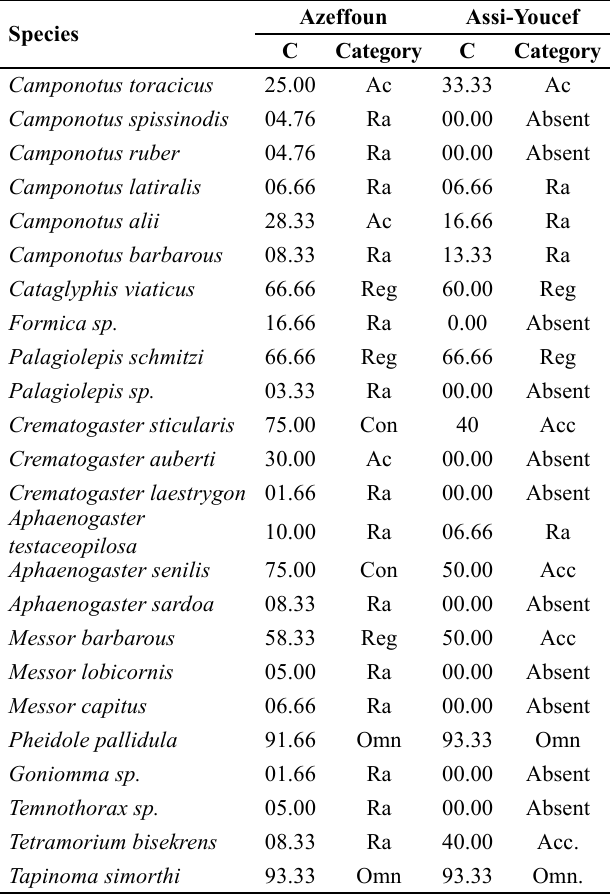
Table 2. Constancy values (C) and their corresponding categories for the two study